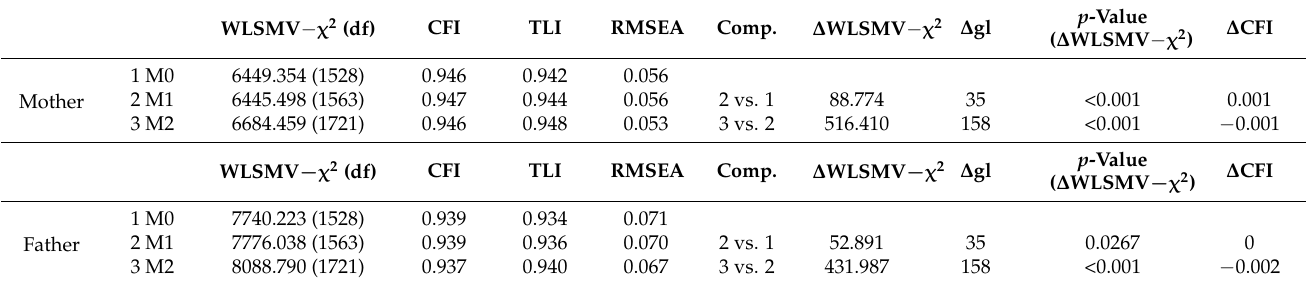
Table 2. Factorial invariance according to sex.